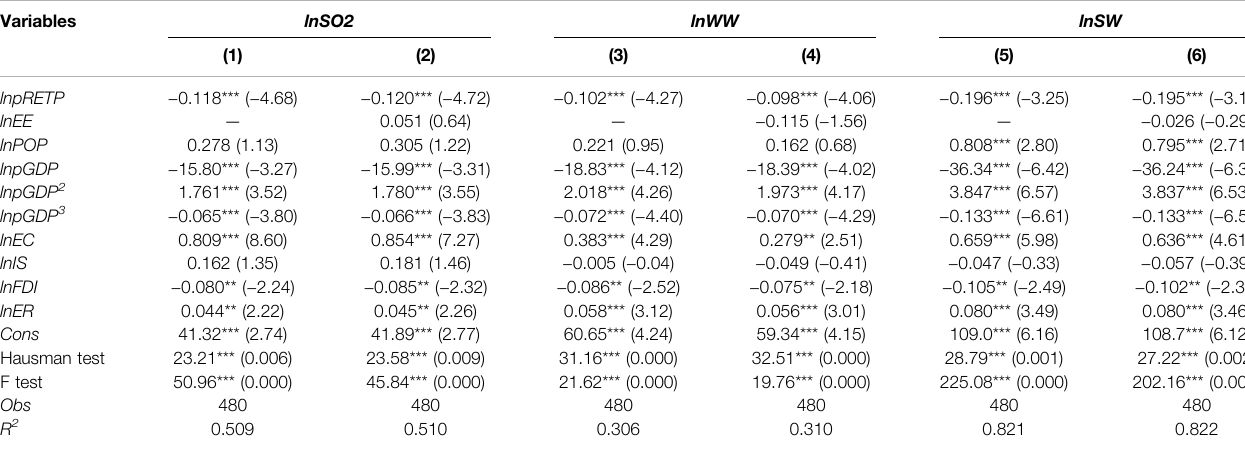
TABLE 7 | Robustness test with an alternative variable in baseline model